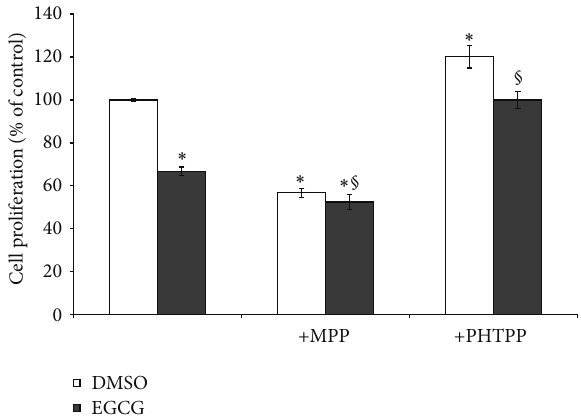
Figure 4: ER 𝛽 -specific inhibitor PHTPP blocks inhibition of cell proliferation by EGCG. MCF-7/BOS cells were pretreated with the ER 𝛼 -specific inhibitor MPP (1 𝜇 M) or the ER 𝛽 -specific inhibitor PHTPP (1 𝜇 M) for 24 hours and then treated with 50 𝜇 M EGCG for an additional 72 hours. Cell numbers were determined by hemocytometer and expressed as a percentage of the DMSO control (set at 100%). Values are expressed as mean ± SE ( 𝑛 = 3 ). ∗ Significantly different compared to control, 𝑃 < 0.05 ; § significantly different compared to treatment with EGCG alone, 𝑃 < 0.05